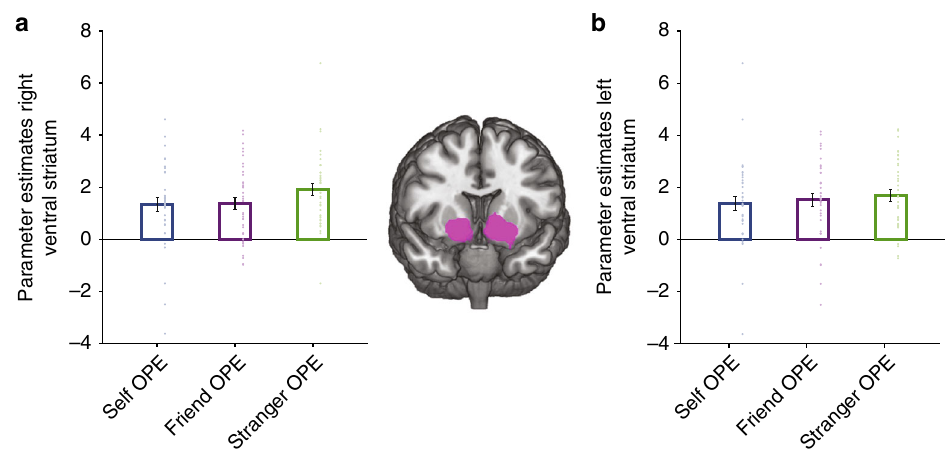
Fig. 3 Common coding of ownership prediction errors (OPEs) for all agents in ventral striatum. Ventral striatum signalled prediction errors for all agents ( p < .001, FWE-whole brain corrected). a Right ventral striatum. b Left ventral striatum. Activation overlaid on an anatomical scan of the coronal surface. Error bars indicate SEM. N = 39